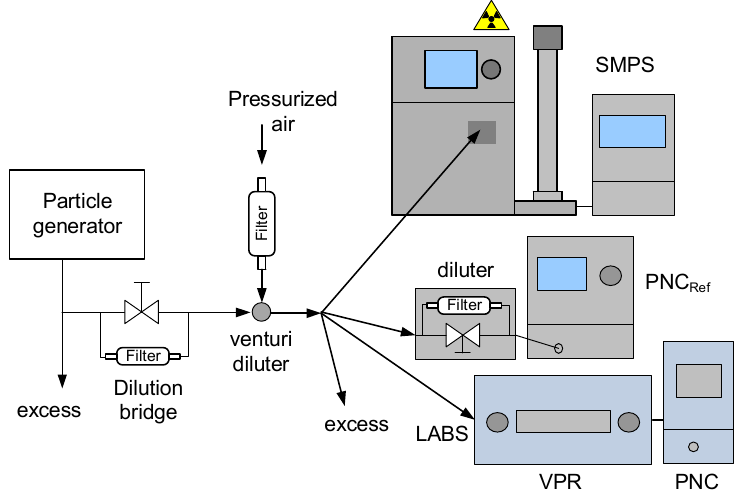
Figure 4. Experimental setup for the polydisperse check (validation) of the VPR + PNC system. PNC = particle number counter; VPR = volatile particle remover.